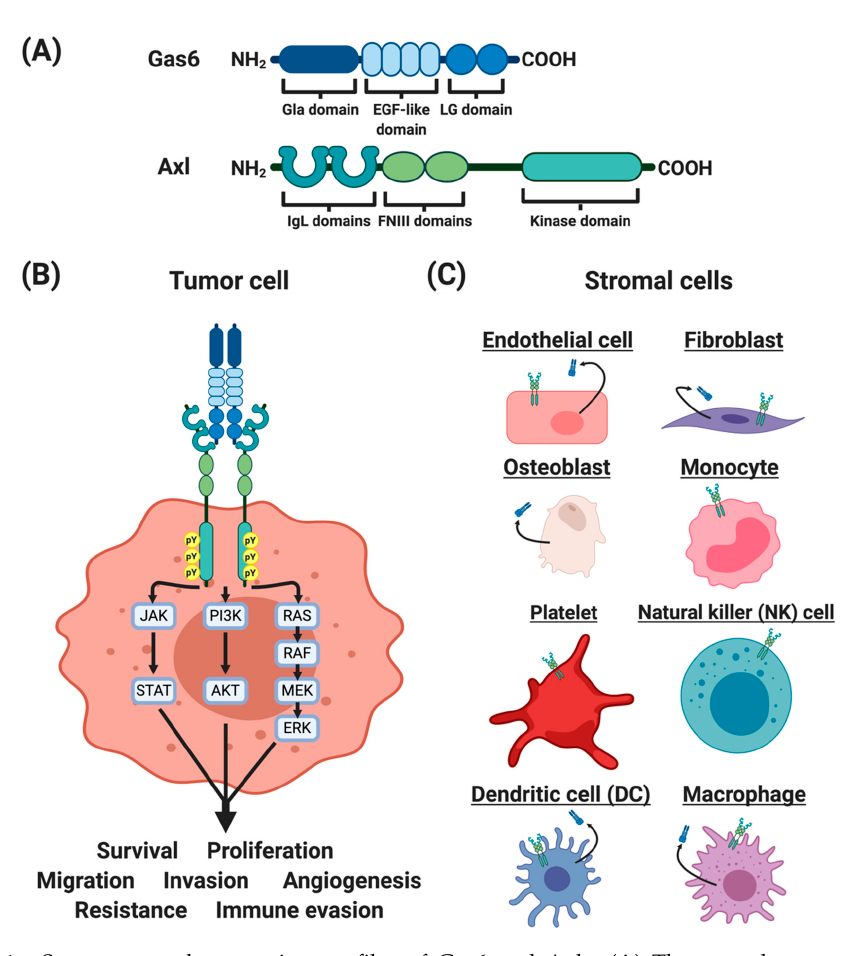
Figure 1. Structures and expression profiles of Gas6 and Axl. ( A ) The growth arrest specific 6 (Gas6) protein belongs in the family of vitamin K-dependent proteins. Gas6 consists of a gamma-carboxyglutamic acid (Gla) domain, four epidermal growth factor (EGF)-like domains, and two laminin G (LG)-like domains. Axl belongs in the Tyro3, Axl, MerTK (TAM) subfamily of the receptor tyrosine kinases. Axl consists of immunoglobulin-like (IgL) domains, two fibronectin domains, and a kinase domain. ( B ) Axl is expressed in a number of tumor types. The Gas6/Axl signaling promotes tumor cell survival, proliferation, migration, invasion, angiogenesis, therapeutic resistance, and immune evasion. ( C ) Gas6 and Axl are expressed by host stromal cells, including endothelial cells, fibroblasts, osteoblasts, monocytes, platelets, natural killer (NK) cells, dendritic cells (DCs), and